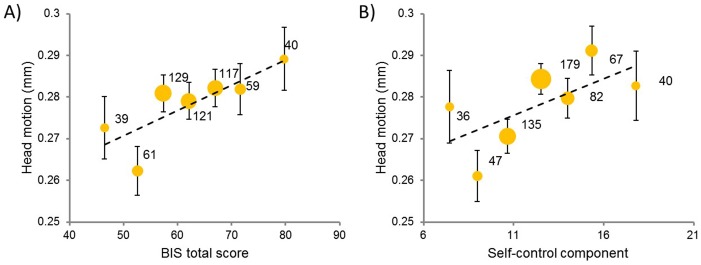
Binned scatter plots between in-scanner head motion and impulsivity indexed by (A) BIS total score, and (B) self-control component score.To avoid overlap for participants with similar scores, participants are binned into groups on the basis of impulsivity scores. The size of dots indicates the number of participants in the groups. Error bars indicate standard error of the mean (s.e.m).